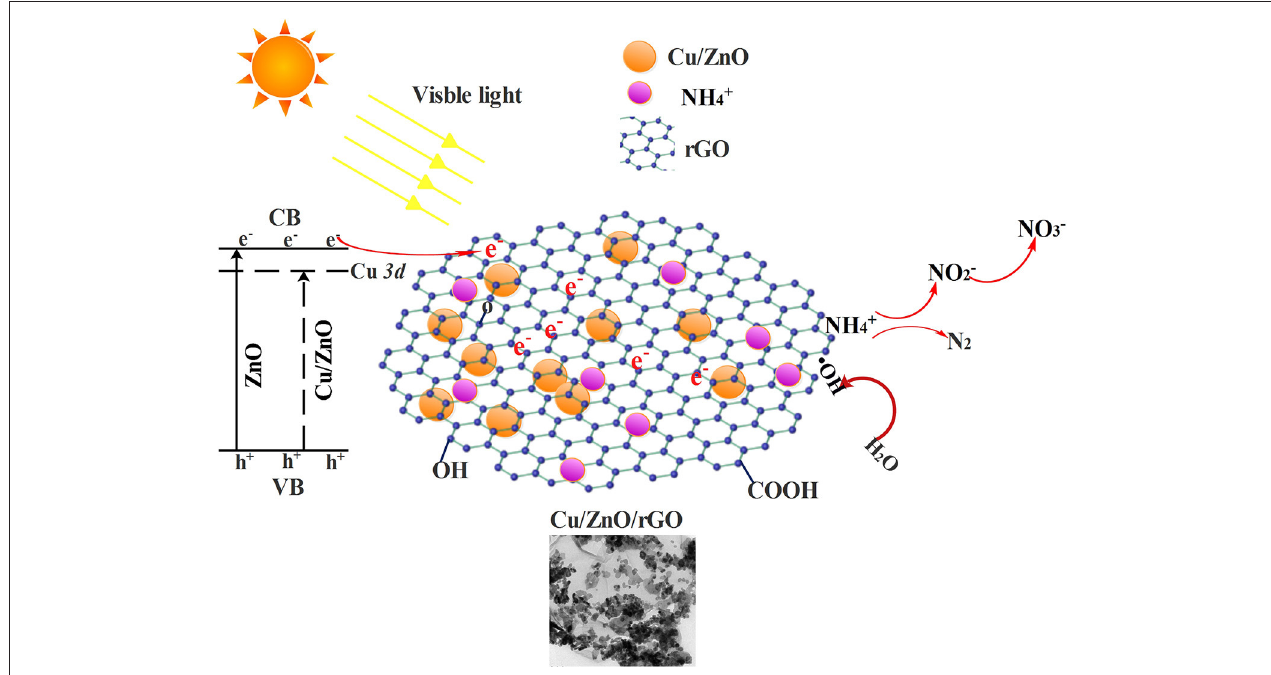
FIGURE 6 | Potential reaction mechanism for NH + 4 -N photo degradation via Cu/ZnO/rGO.